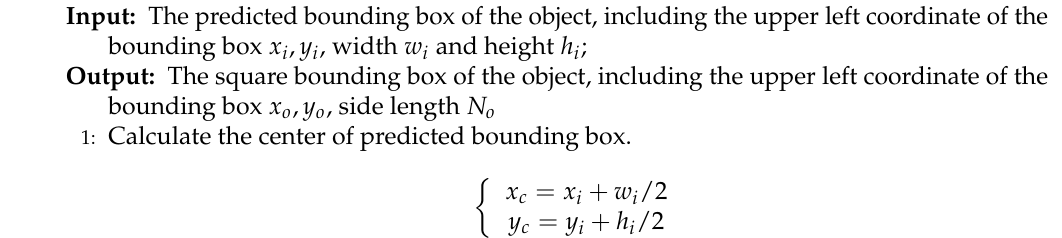
Algorithm 1 calculation of the output bounding